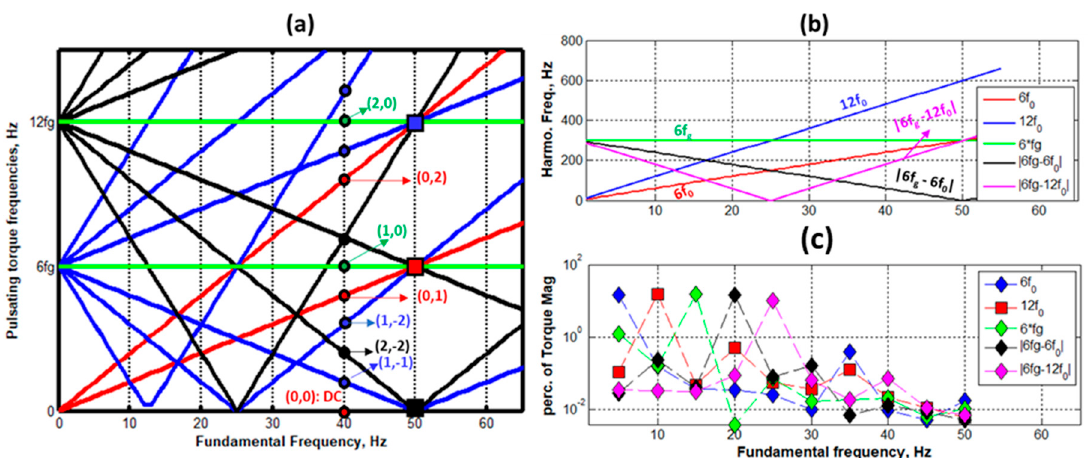
Figure 19. Summary of simulation results of a 6/6-pulse LCI system: ( a ) Campbell diagram with specific parameters (𝑚,𝑛) to localize the simulated torque harmonics at 40 Hz, ( b ) relevant air-gap torque harmonic families and ( c ) magnitudes of relevant air-gap torque components for each harmonic family.